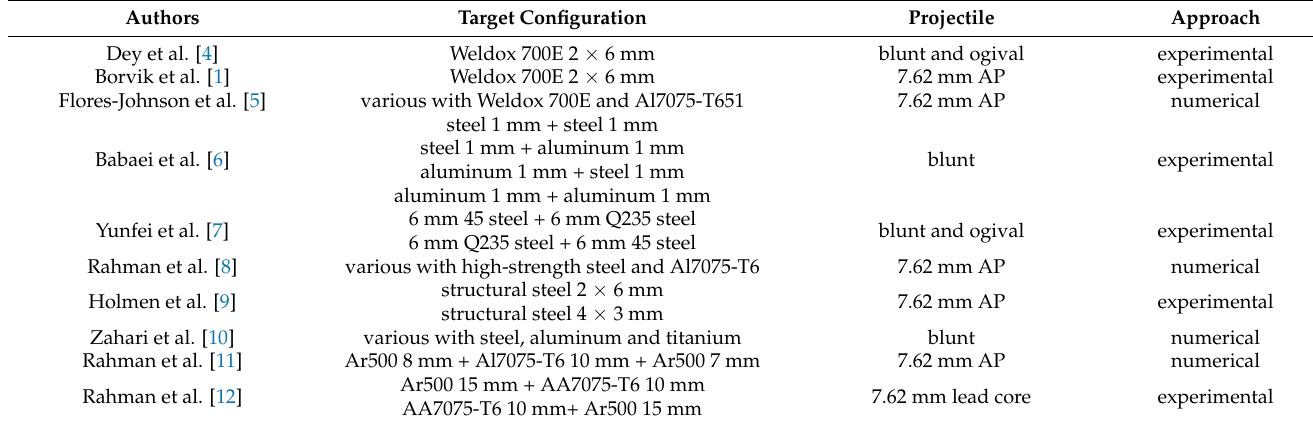
Table 1. Studies about the effect of layering and the order of layers of different